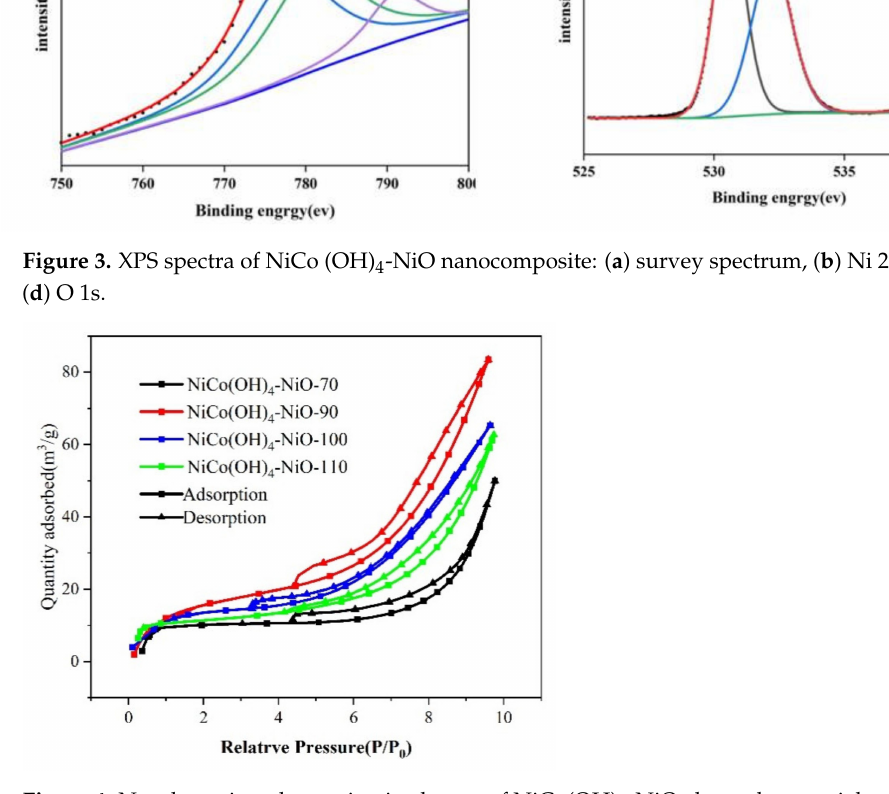
Figure 4. N 2 adsorption–desorption isotherms of NiCo(OH) 4 -NiO electrode